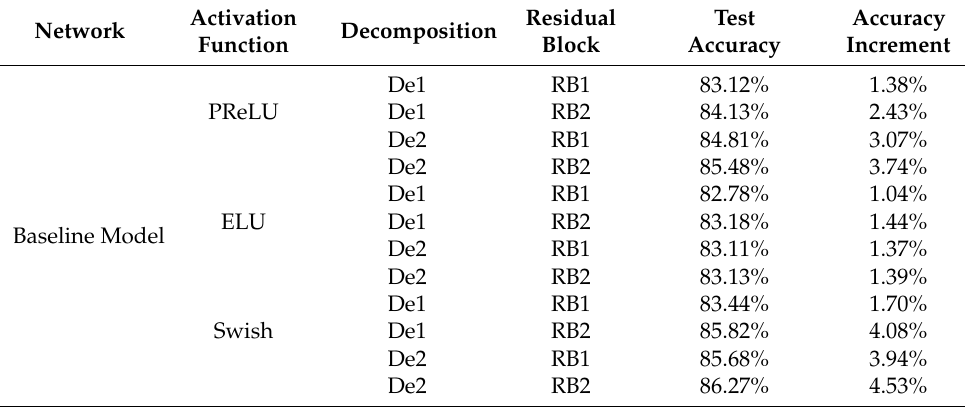
Table 7. Test results of different structural combinations.